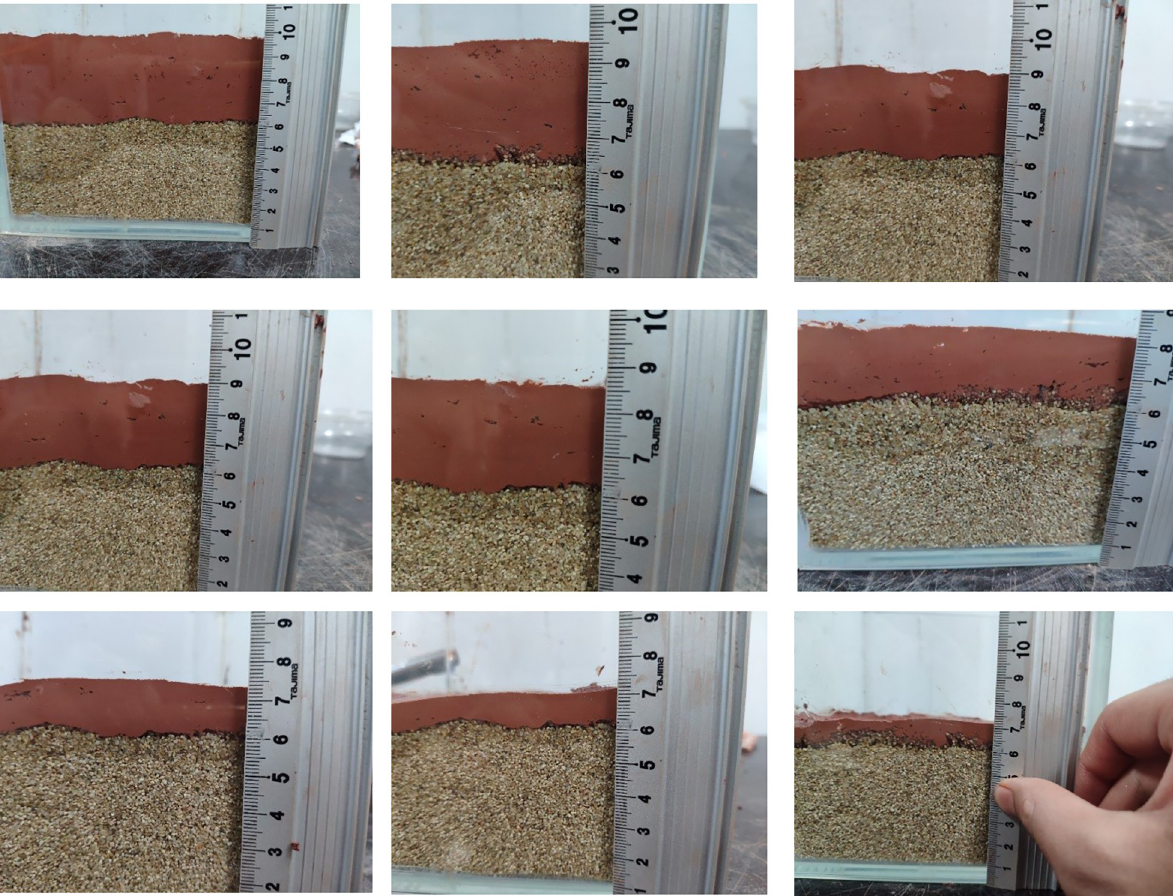
Fig 11. Thickness of weathered soil film for each of the 9 groups of tests (A) No. 1; (B) No. 2; (C) No. 3; (D) No. 4; (E) No. 5; (F) No. 6 (G) No. 7; (H) No. 8; (I) No. 9.